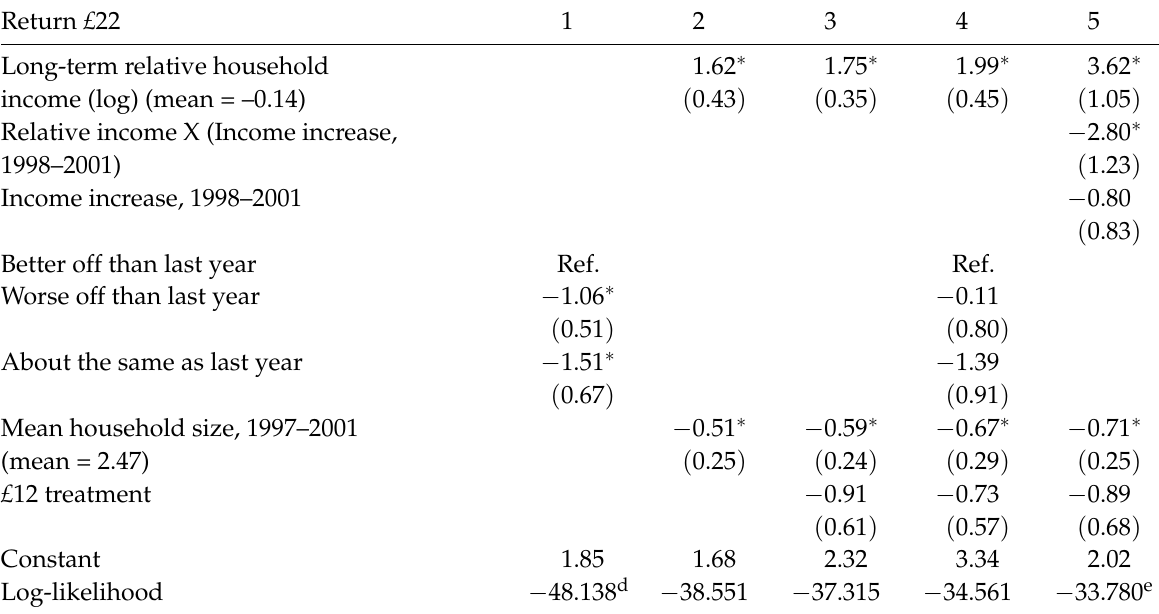
Table 2: Logit regression of impacts of relative income on